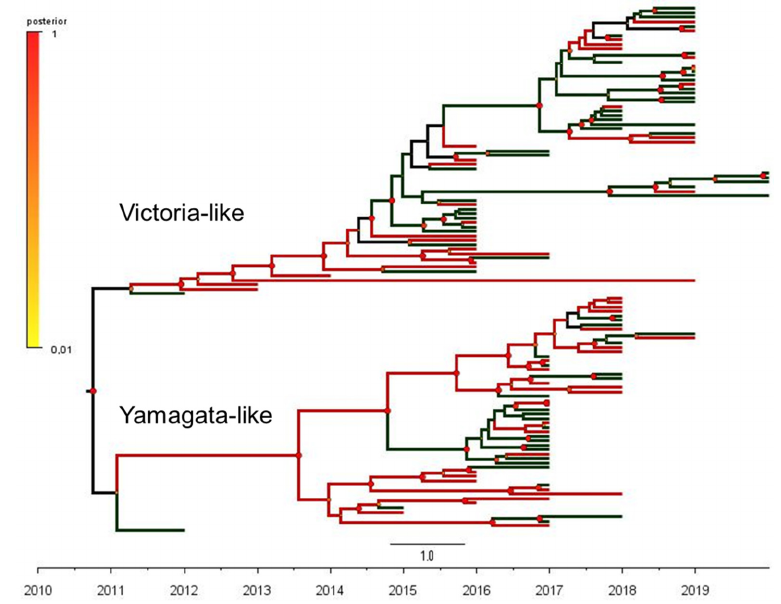
Figure 1. The phylogeny–trait analysis based on the maximum clade credibility (MCC) phylogenetic tree of 118 complete sequences of the influenza B hemagglutinin gene (1714 bp) from B/Victoria-like (66 sequences) and B/Yamagata-like (52 sequences) antigenic lineages circulating in Brazil, 2010–2020. Table 2. Results of phylogeny trait association tests for viral lineages (B/Victoria and B/Yamagata) and disease severity (SARI and ILI).